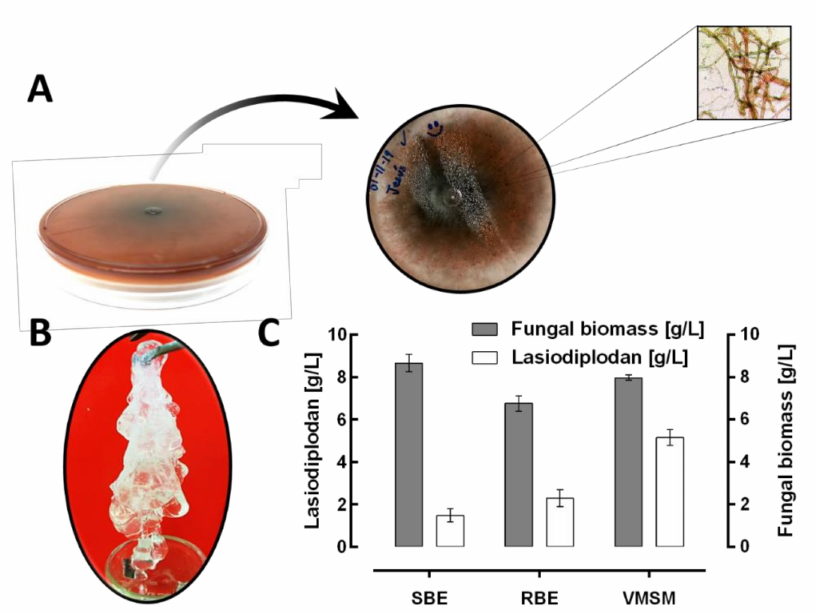
Figure 1. Lasiodiplodan production by L. theobromae CCT 3966: ( A ) Fungal growth on YMG agar exhibiting red pigmentation; ( B ) Lasiodiplodan recovered after fermentation; ( C ) Impact of crude nitrogen sources on fungal biomass and lasiodiplodan accumulation using synthetic glucose